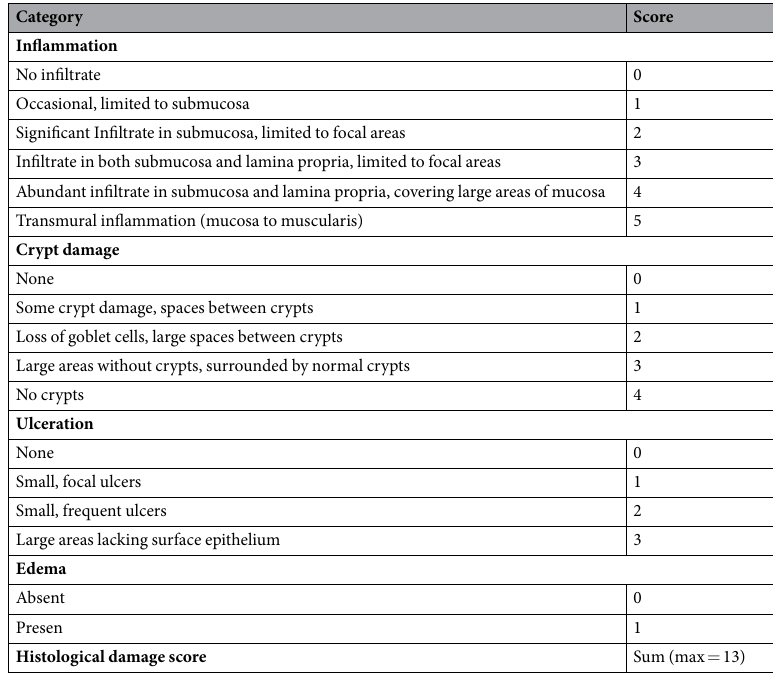
Table 4. Histological damage scoring system for quantitative evaluation of the colon